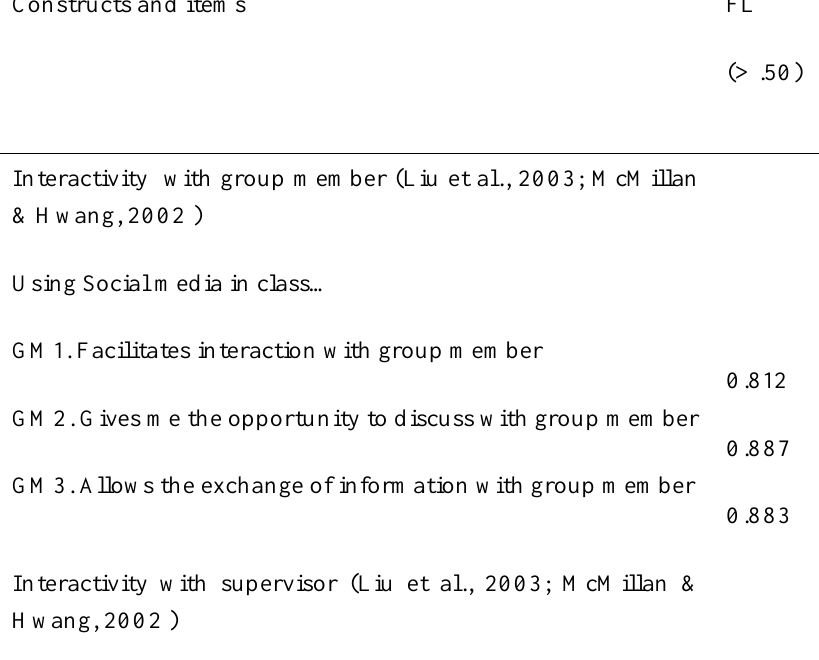
Constructs, Items, and Confirmatory Factor Analysis Results Constructs and